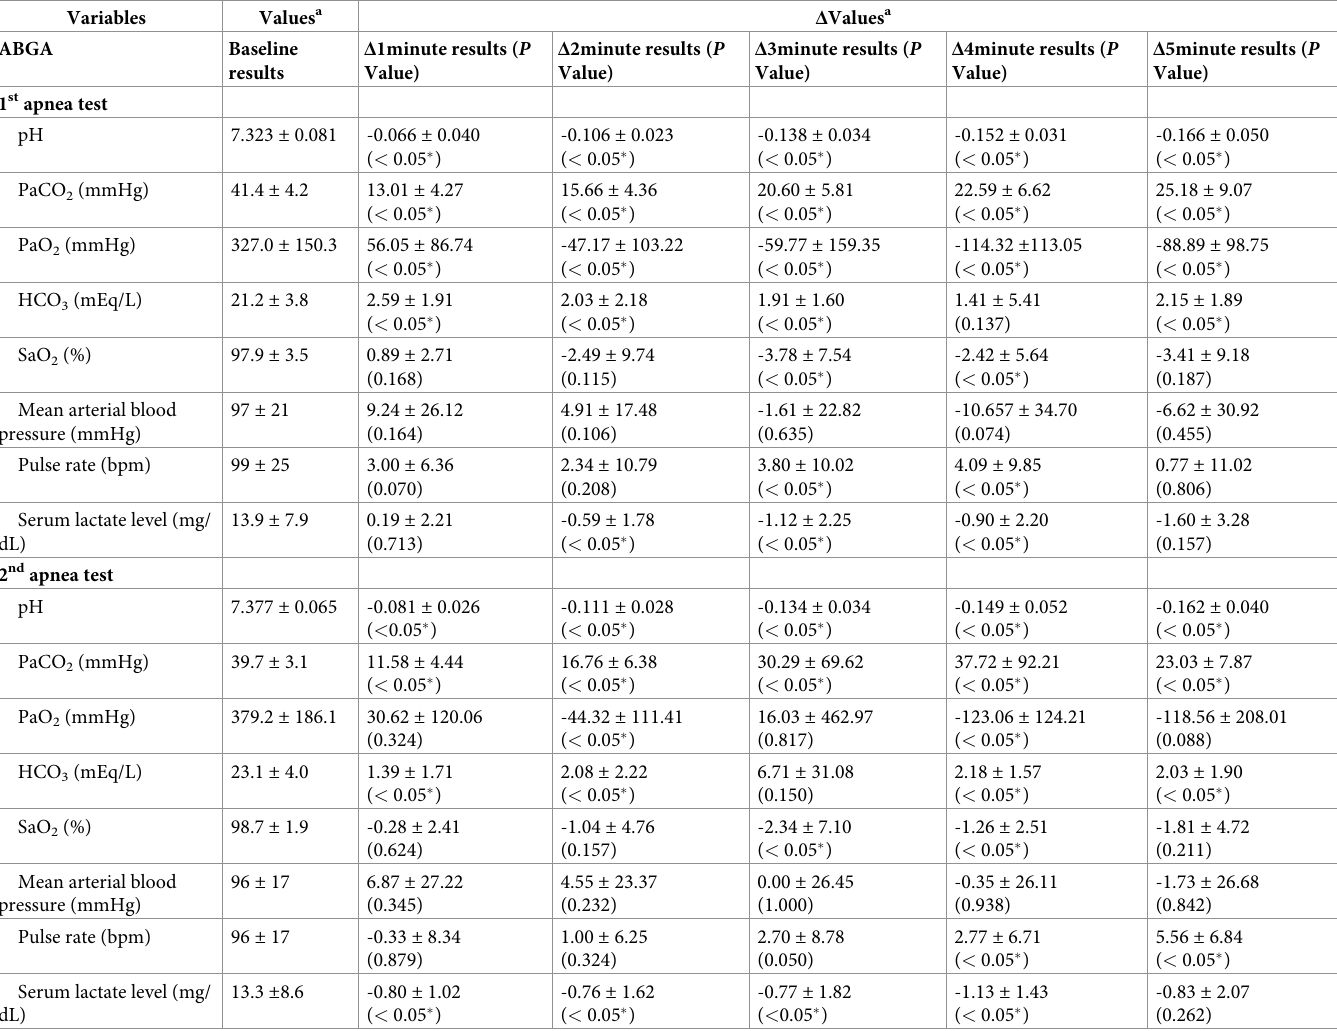
Table 2. 1 st and 2 nd apnea test